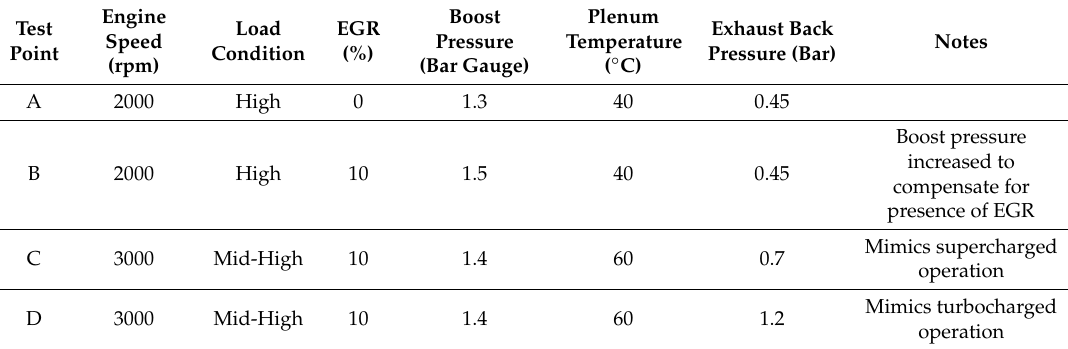
Table 3. Test operating points for Ultraboost engine